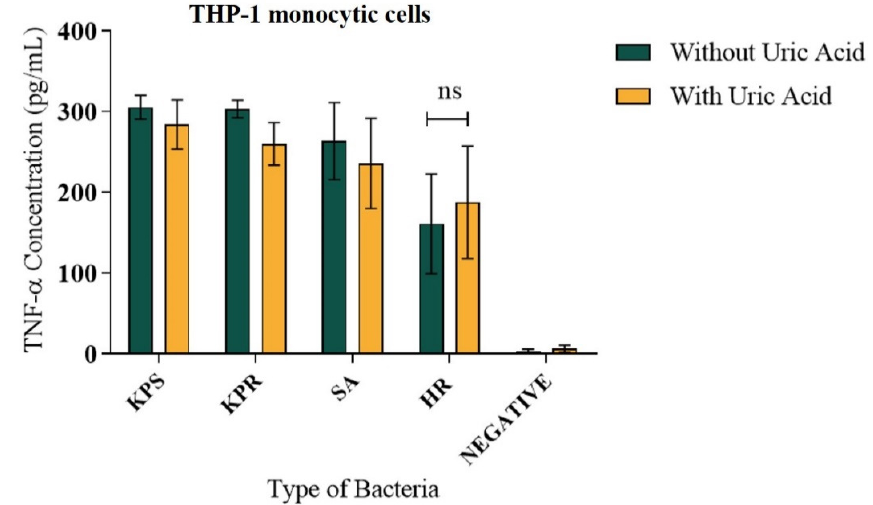
Figure 5. TNF α release from infected human THP-1 monocytes in presence of soluble uric acid. Human THP-1 monocytic cells were infected with formalin-fixed bacteria in presence and absence of soluble uric acid (19 mg / dL) and incubated overnight. IL-1 β release in the supernatants was quantitated using ELISA method. These data represent the mean of six independent experiments with bars showing the standard error of the mean. KPS: K. pneumoniae sensitive; KPR: K. pneumoniae resistant; SA: S. aureus ; MRSA HR: methicillin-resistant S. aureus with high resistance; UA: uric acid; ns: not significant.